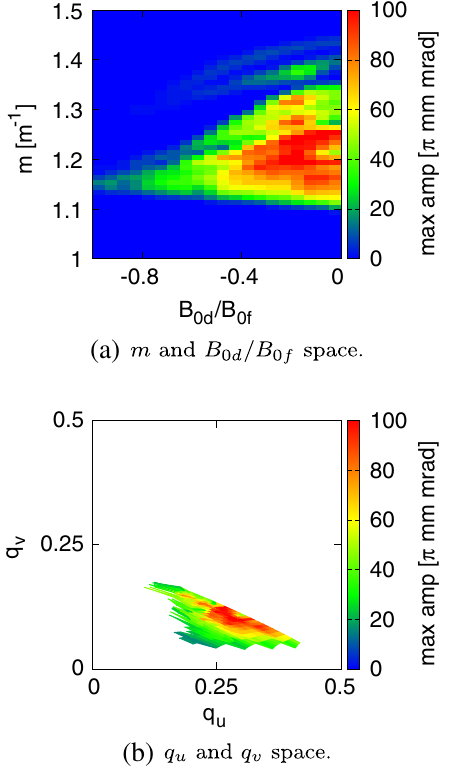
=B 0 FIG. 6. (a) stable area in m and B 0 space, (b) stable area in d f q and q space. The colour code indicates the maximum u v þ j Þ A amplitude of betatron oscillation A ¼ ð i 0 where max max A 0 ¼ 5 π mm mrad in normalised space, i and j are the max max indices corresponding to the largest value of i for u space or j for v space for which the particle survives 100